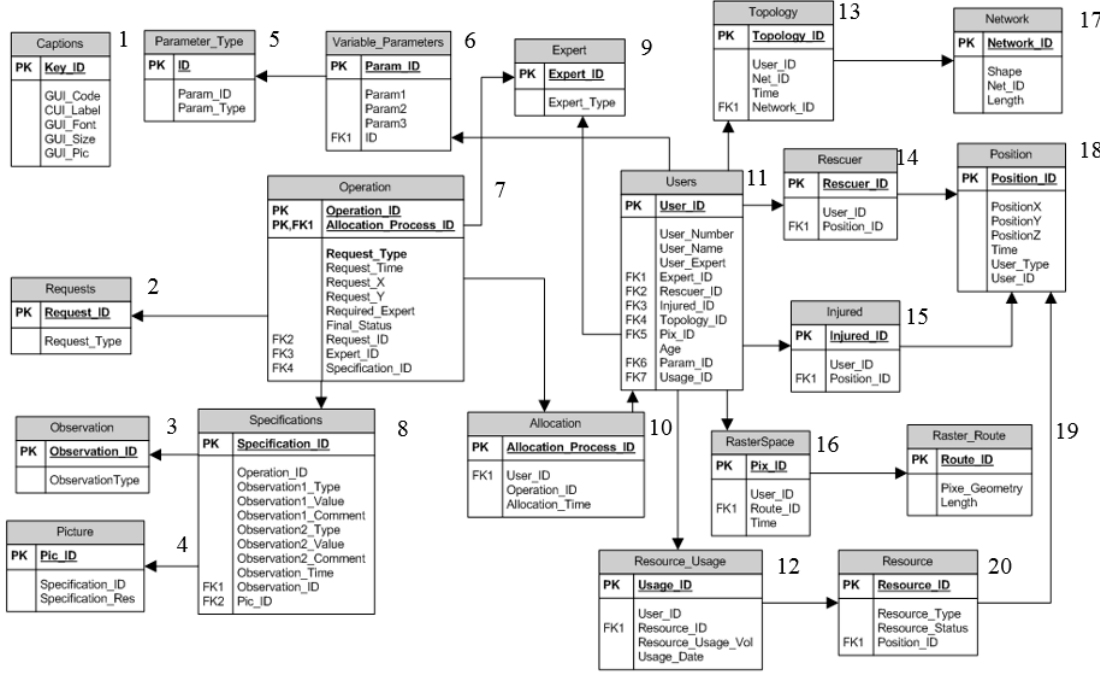
Figure 7. Relational database of system main objects.